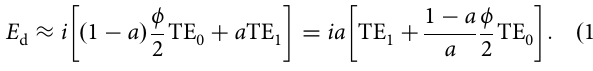
be measured on one of the arms with a micro-heater. Then light in each arm goes through a spatial phase front tilter and undergoes an opposite spatial phase front tilt. They interfere at another multi-mode 50/50 directional coupler. Finally, at the dark port, light goes through a multimode interfering (MMI) region as the readout of the spatial fi eld pro fi le shift. The optical power difference between the two outputs of the MMI contains the desired phase signal. The enhancement of the signal is deter- mined by the amount of spatial phase front tilt.